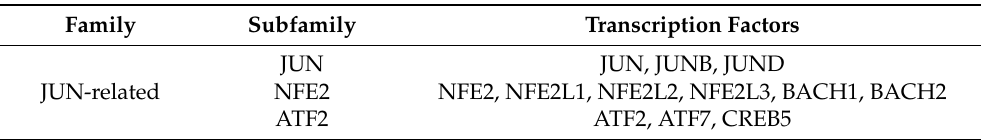
Table 1. Classification of transcription factors members of the class of bZIP transcription factors according to the TFClass nomenclature [1].